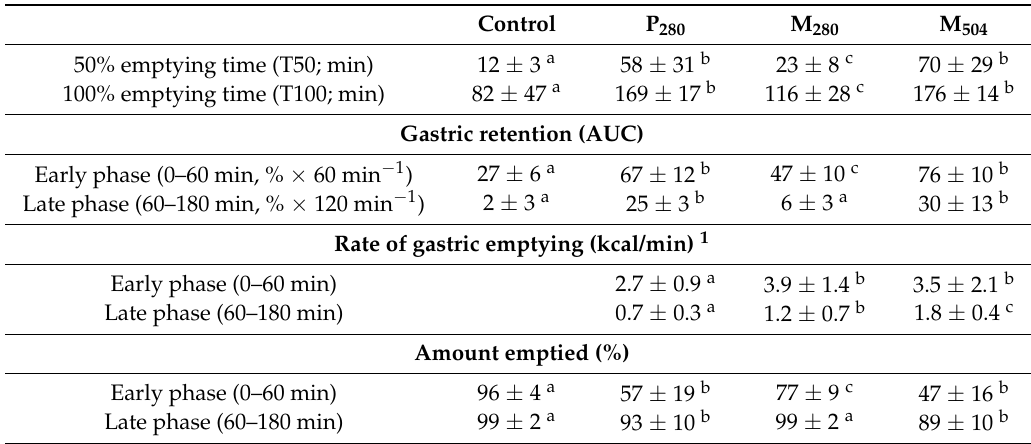
Table 2. Gastric emptying